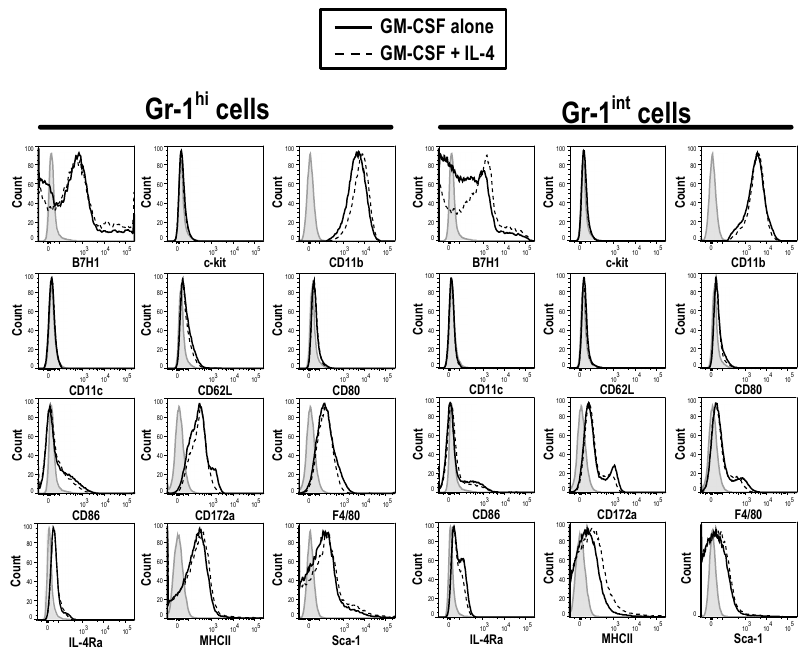
Figure 4. The phenotype of Gr-1 hi and GR-1 int cells from GM-CSF and GM-CSF + IL-4 derived BM cultures is consistent with the presence of MDSCs. Live cells from GM-CSF derived BM culture were characterized on day 3. Cells generated from BM with GM-CSF (10 ng/mL) (solid line) or GM-CSF (10 ng/mL) + IL-4 (5 ng/mL) (dotted line) were characterized with a panel of phenotypic markers, chemokine receptors and activation markers. The shaded grey area represents unstained control cells. Results shown are representative of three mice.